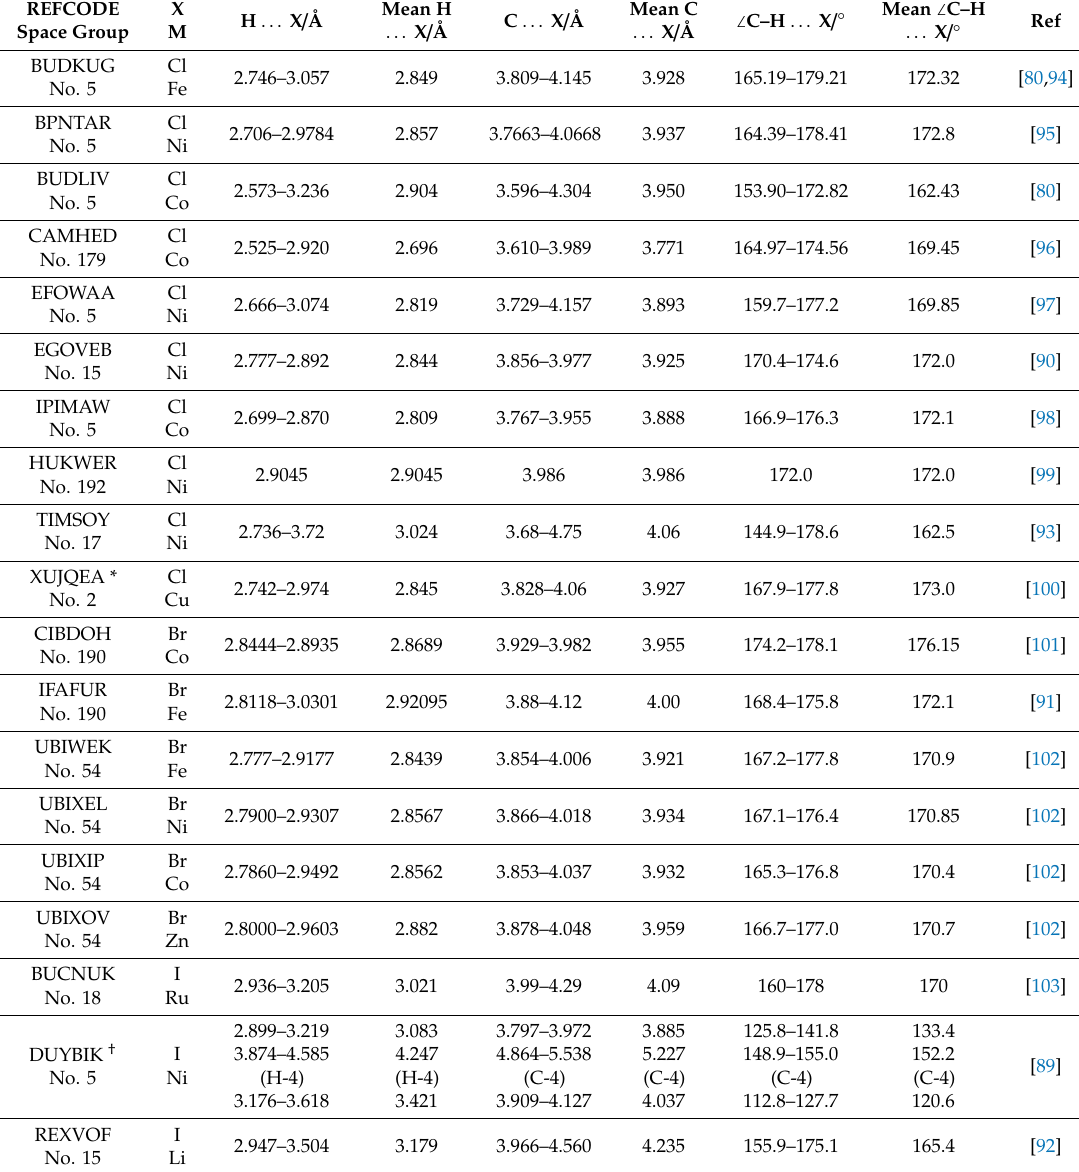
Table 2. Structure Type 1